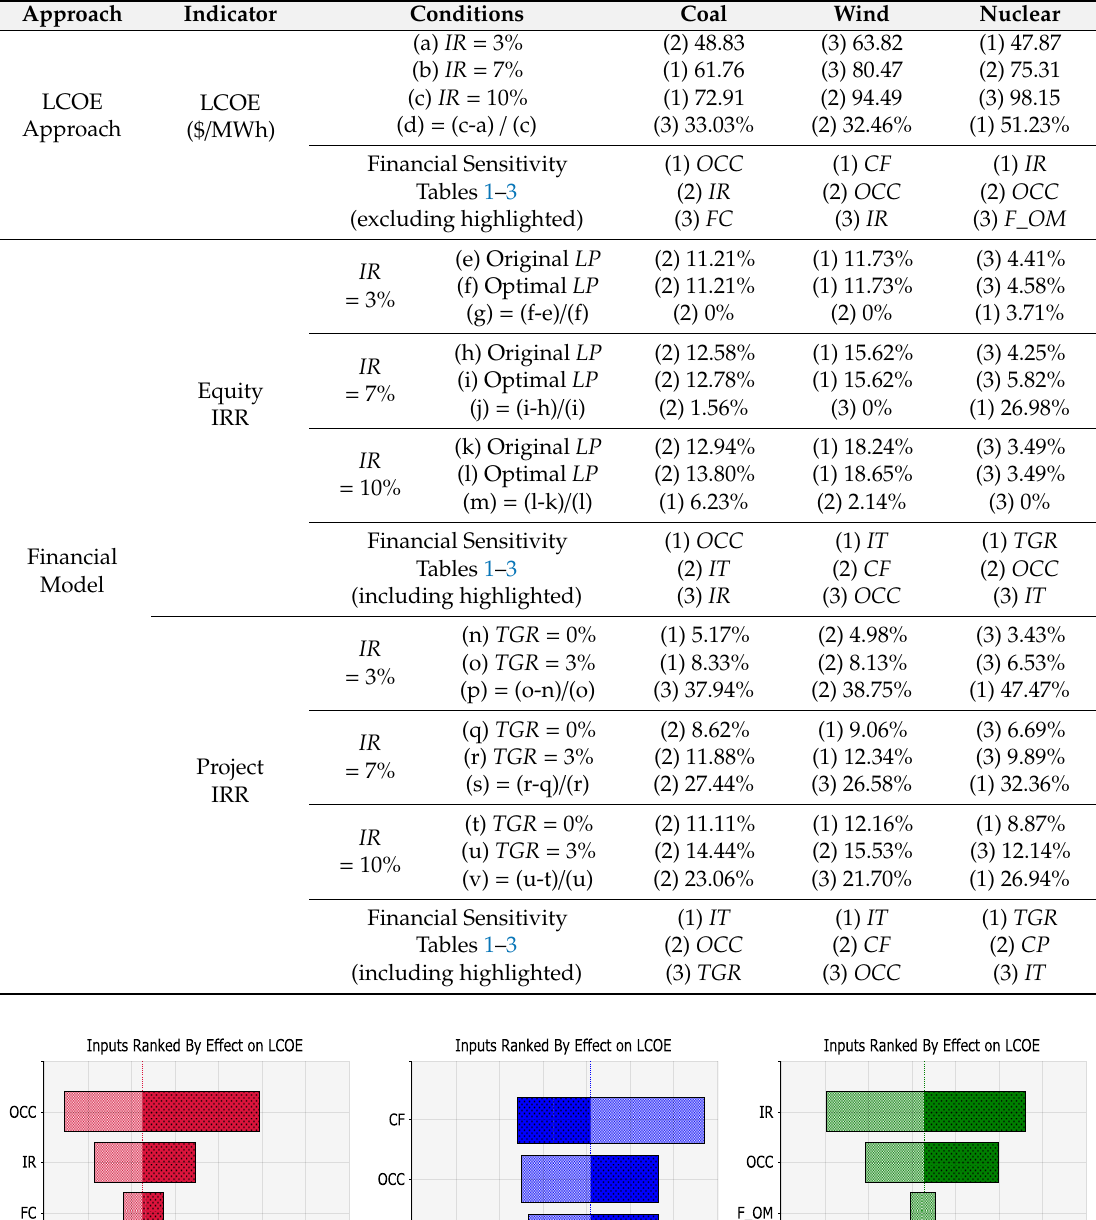
Table 9. Summary of the results of the LCOE approach and financial model analysis.